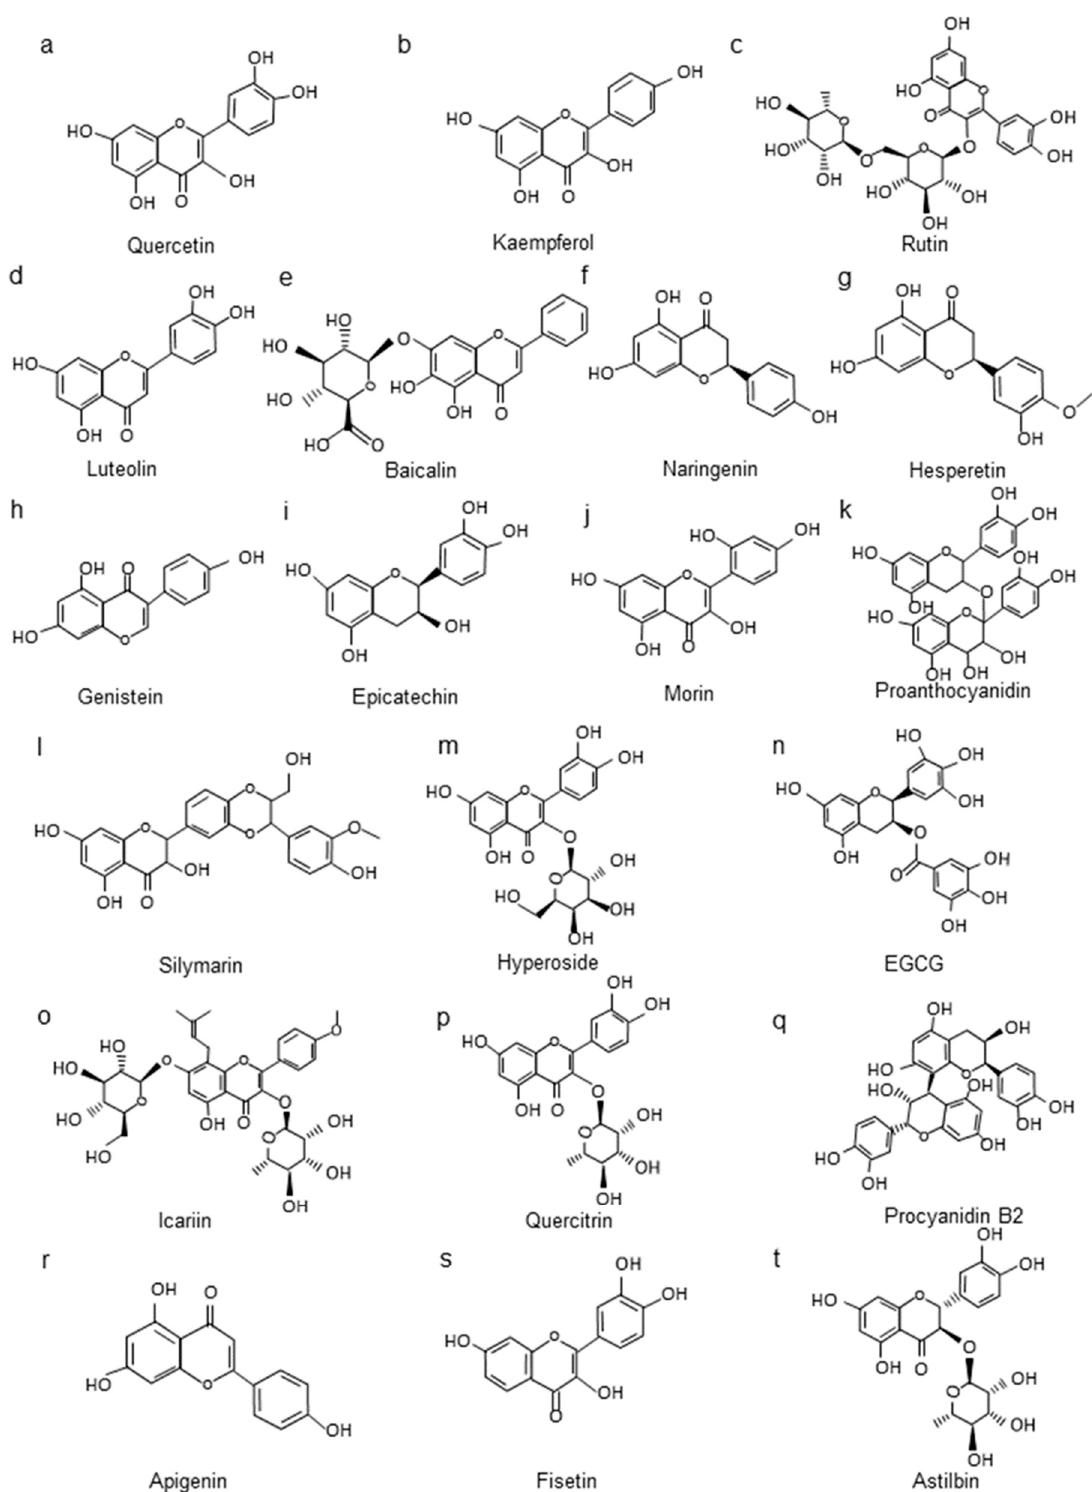
Figure 2. The chemical structures of the flavonoids discussed in CKD. ( a – t ): the flavonoid substances and their structural formulas mentioned in CKD.